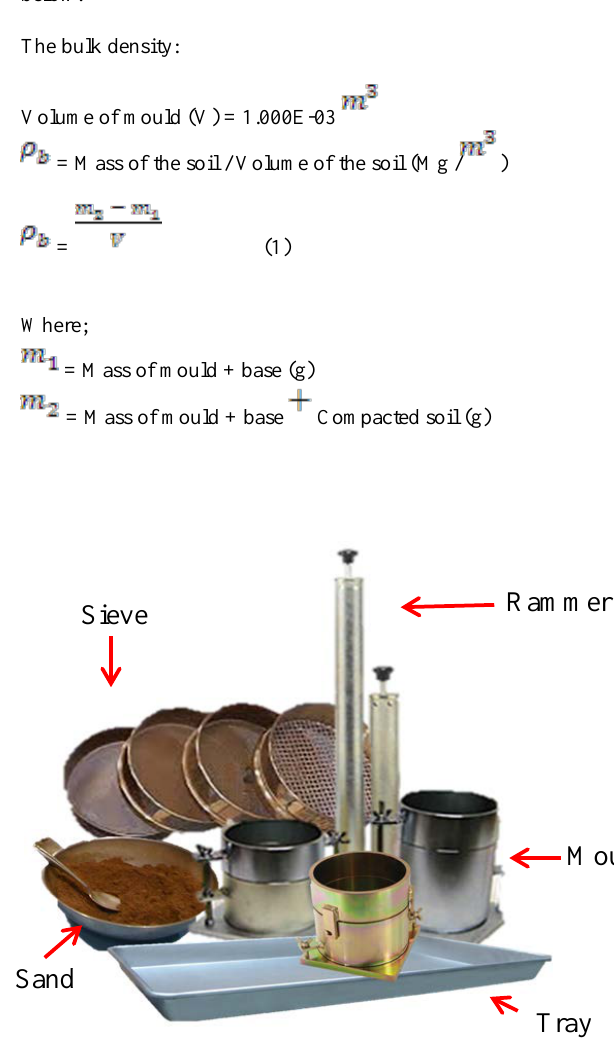
Figure 1 . soil compaction